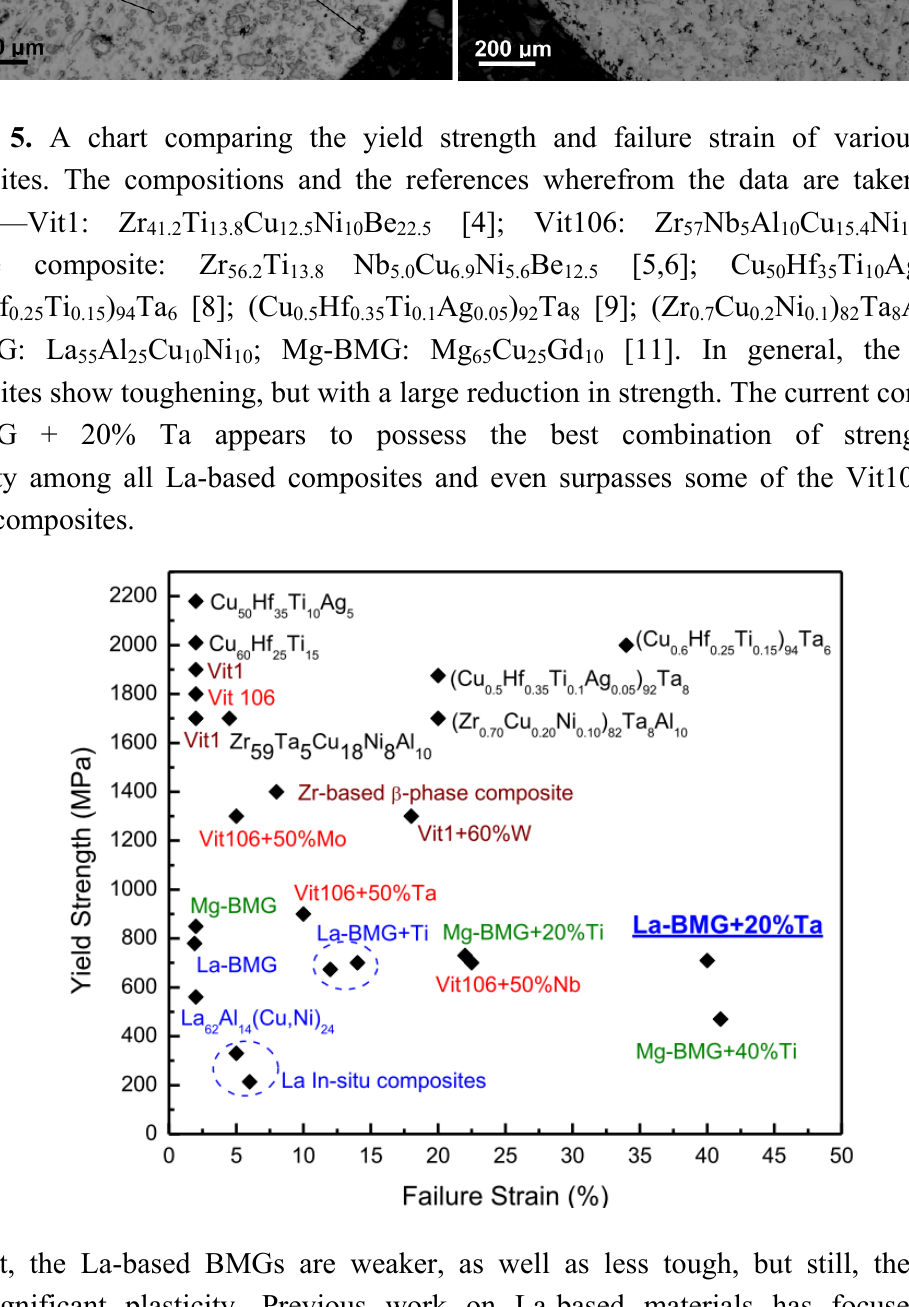
Al Cu Ni )-Ta composites from ( a ) rod 1 and 55 25 10 10